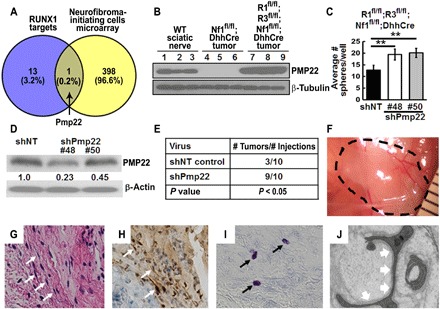
Loss of Nf1 mediated PMP22 functions as tumor suppressor to contribute to neurofibroma initiation.(A) Venn diagram showed the overlap of the 14 RUNX1/3 target genes with human neurofibroma-initiating cell microarray DEGs. (B) Western blot of PMP22 in WT mouse sciatic nerves (1 to 3), Nf1fl/fl;DhhCre tumors (4 to 6), and Runx1fl/fl;Runx3fl/fl;Nf1fl/fl;DhhCre tumors (7 to 9). β-Tubulin was used as a loading control. (C) ShPmp22 partially rescued numbers of Runx1fl/fl;Runx3fl/fl;Nf1fl/fl;DhhCre spheres. **P < 0.01. (D) Western blot showed the levels of Pmp22 knockdown by shPmp22. Numbers indicated the percentage of knockdown. (E) Neurofibroma-like lesions formed after subcutaneous injection of shNT- or shPmp22-transduced Runx1fl/fl;Runx3fl/fl;Nf1fl/fl;DhhCre DRG/neurofibroma-derived sphere cells. Statistics: Fisher’s exact test. P < 0.05. (F) A representative gross photograph of a lesion (dashed black circle) under reflected skin in a nu/nu mouse injected with shPmp22-transduced Runx1fl/fl;Runx3fl/fl;Nf1fl/fl;DhhCre DRG/neurofibroma-derived sphere cells. Ruler showed 1-mm markings. (Photo credit: Ashley Hall and Jianqiang Wu). (G) H&E-stained section of the tumor from (G) showed spindle cells (white arrows). (H) IHC showing S100β+ cells (brown; white arrows) in tumor. Blue is H&E counterstain. (I) Toluidine blue staining showed mast cells (black arrows). (J) Electronic micrograph showed lesions containing SCs, identified by continuous basal lamina in high magnification (white arrows).